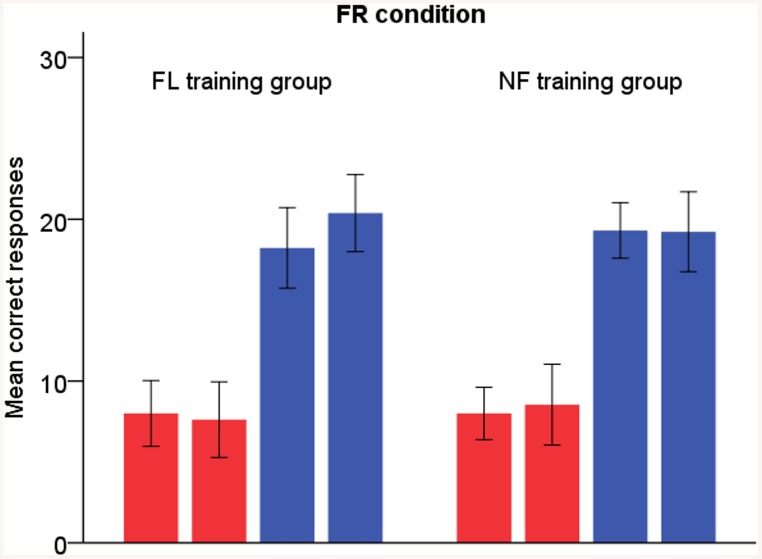
FR condition.Red bars = left-ear responses, blue bars = right-ear responses. The left-sided bar of each two bars of the same colour represents pre-training results and the right-sided bar post-training results. Error bars display 95% confidence interval for mean.